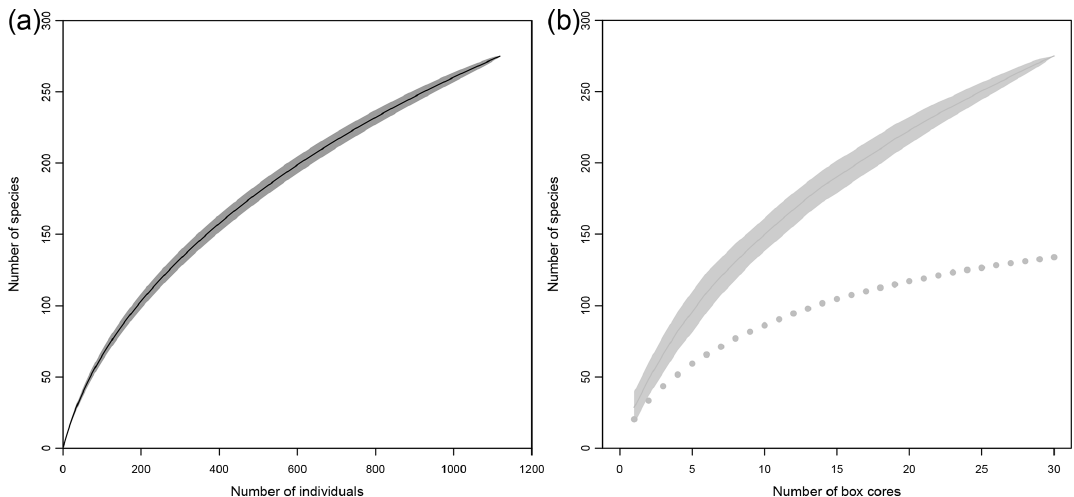
Figure 10. Rarefaction curves based on individuals (a) and samples (b) within the eastern CCFZ. The dotted curve shows the sample-based rarefaction curve of